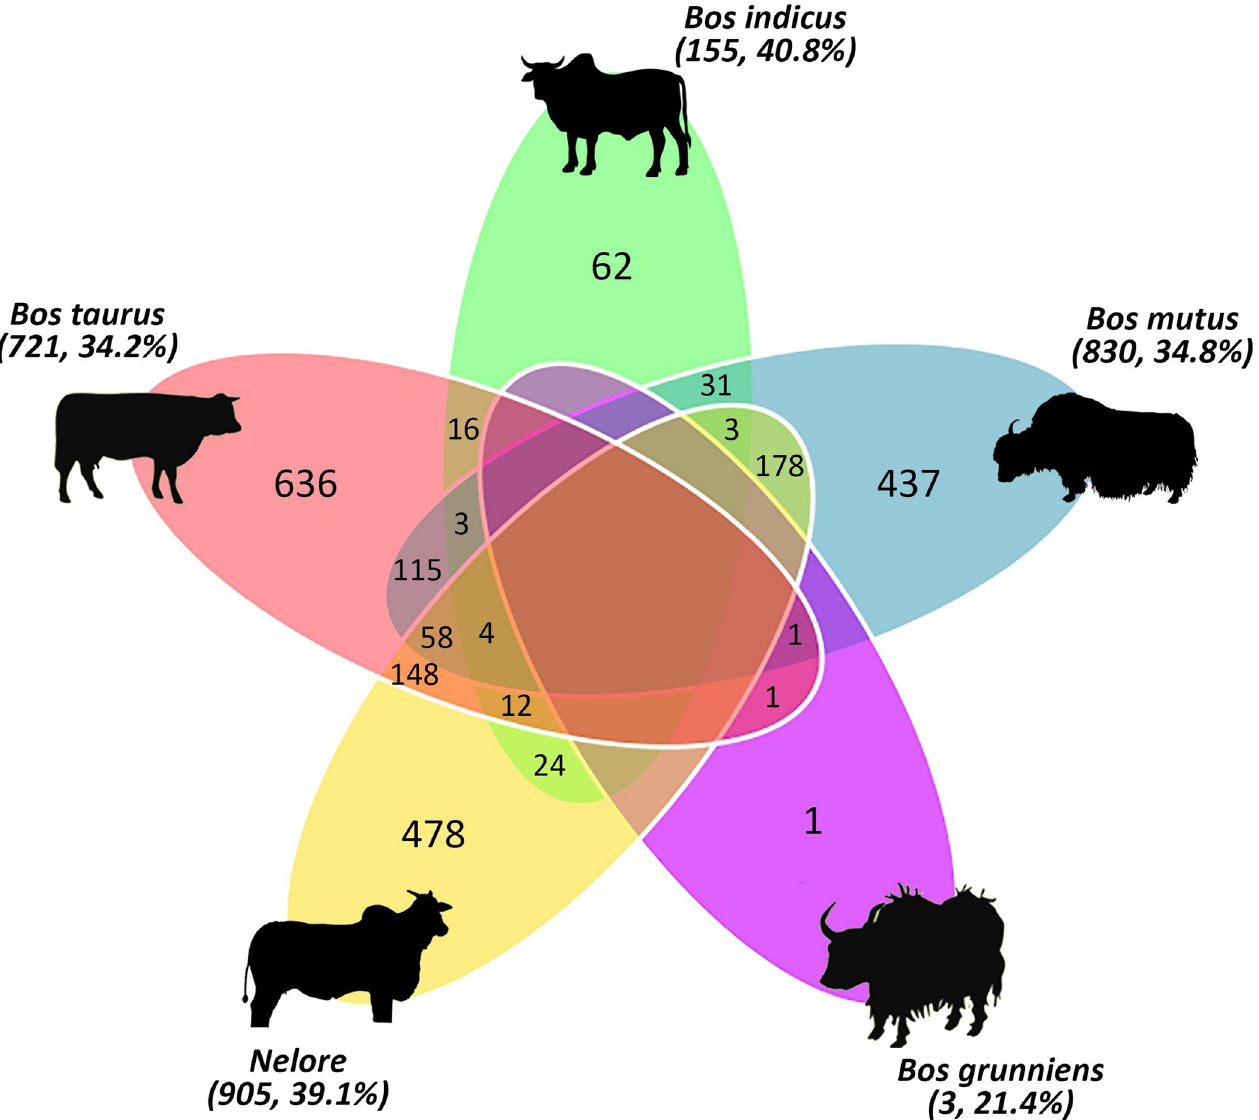
Fig 4. Venn diagram of OGs under positive selection in Bovinae species. Image constructed in http://www.interactivenn.net/ and obtained using multiple lists of OGs with ω > 1 per